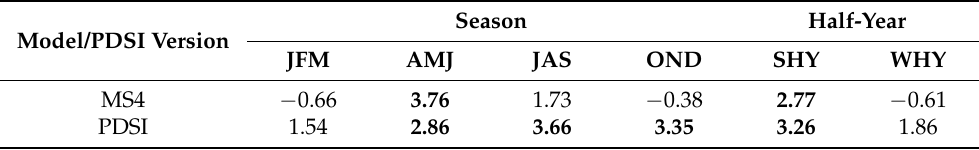
Table 3. Linear trends in the area exhibiting 10th ‐ percentile soil drought (% of grid points per 10 years) in the 0–100 ‐ cm soil layer according to MS4 and PDSI for JFM, AMJ, JAS, OND, SHY, and WHY in the Czech Republic during the 1961–2020 period. Statistically significant linear trends, at a 0.05 significance level, appear in bold type.